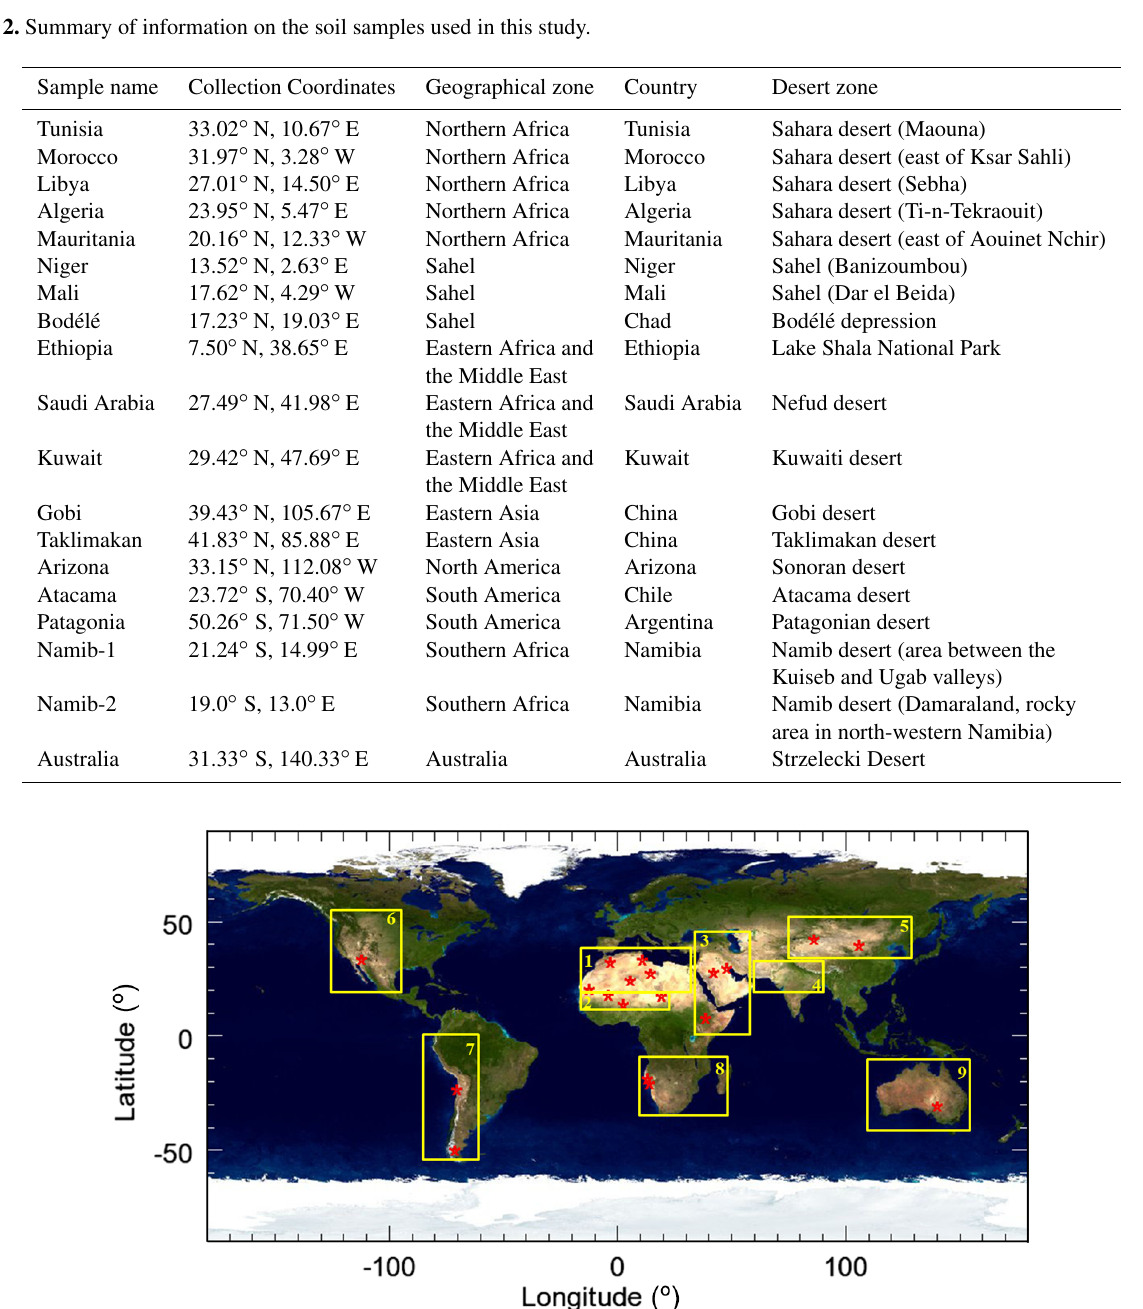
Figure 2. Location (red stars) of the soil and sediment samples used to generate dust aerosols. The nine yellow rectangles depict the different global dust source areas as defined in Ginoux et al. (2012): (1) northern Africa, (2) the Sahel, (3) eastern Africa and Middle East, (4) central Asia, (5) eastern Asia, (6) North America, (7) South America, (8) southern Africa, and (9)